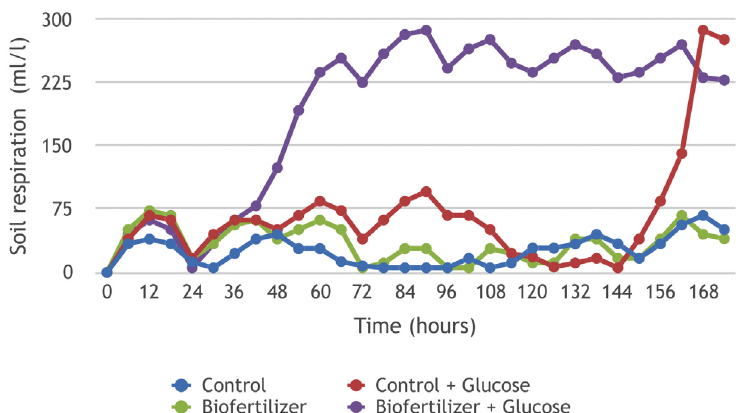
Figure 2. This sample shows CO values periodically decreasing in all conditions. After examining the Oxitop device’s operation, this 2 pattern became more interesting to us, as the device quantifies CO production by measuring BOD required for the degradation of organic 2 matter. From the decreasing CO values, we conclude that there was oxygen production and/or CO consumption in the Oxitop bottles. 2 2